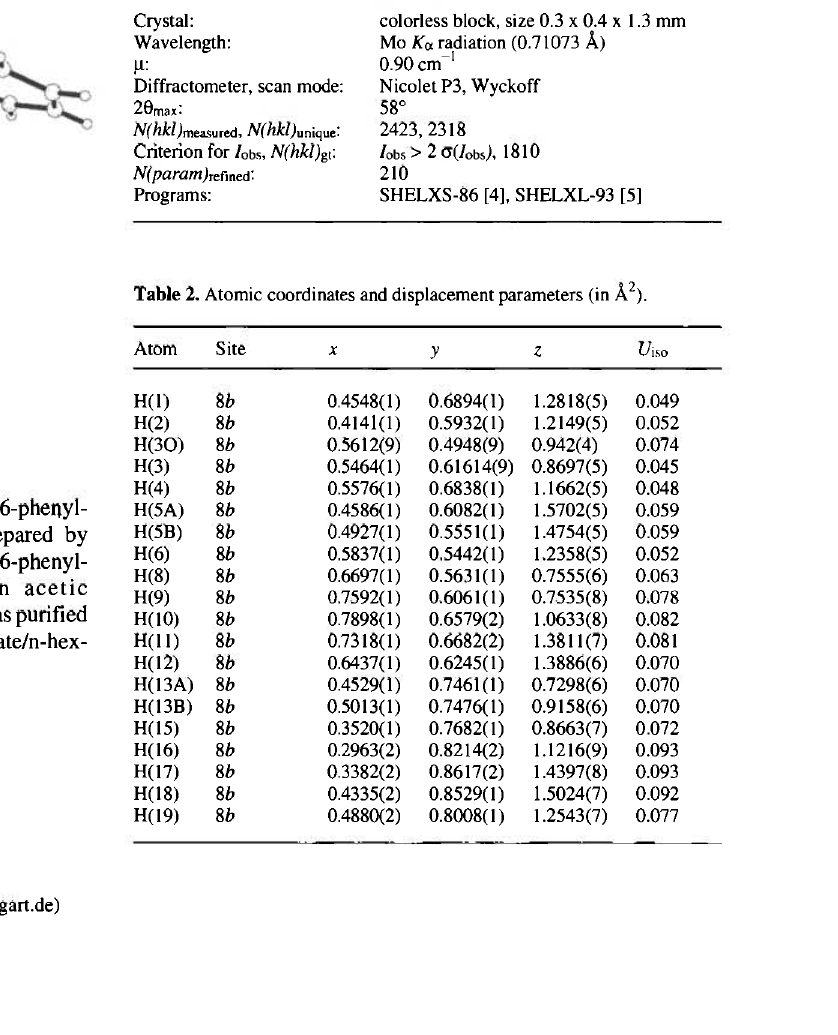
Table 1. Data collection and handling.